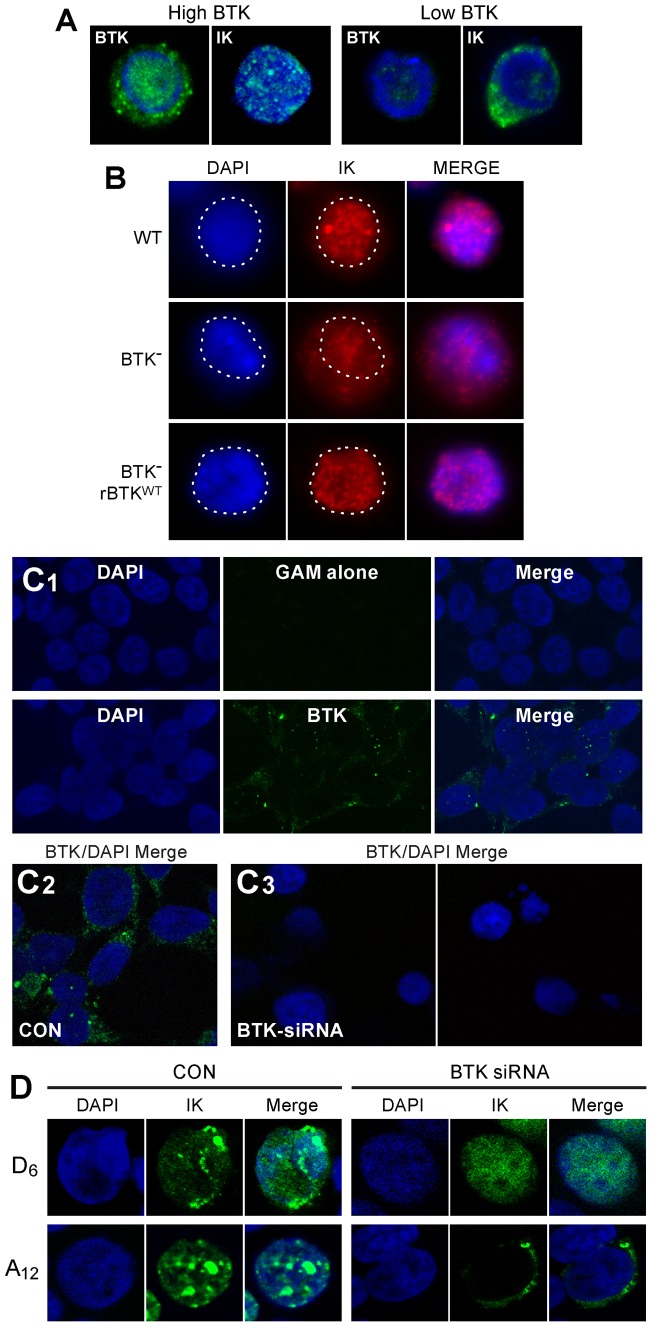
BTK Expression Levels Control Nuclear Localization of Ikaros.[A] Cells were stained with mouse monoclonal antibody (mAb) against human BTK and an anti-IK mouse mAb, which was raised against murine IK and which cross-reacts with human IK. TOTO-3 was used for nuclear staining. Depicted are the confocal two-color (green/blue: BTK/TOTO-3 and IK/TOTO-3) merge images of abundantly BTK+ (high BTK) leukemic cells from a pediatric B-precursor ALL case vs. leukemic cells with low BTK expression level from an infant B-precursor ALL case. Nuclear staining for IK was observed in the confocal fluorescence images of primary leukemic B-cell precursors with high BTK expression level. By contrast, leukemic cells with low BTK expression levels showed an aberrant, predominantly cytoplasmic localization of IK (System Magnification: 500×). [B] The DT-40 cell line and its subclones were stained with the rabbit polyclonal, H-100 (sc-13039) antibody against the N-terminus of IK. Depicted are the confocal two-color (red/blue) IK/DAPI merge images of wildtype (WT) DT40 cells, BTK-deficient DT40 cells, and BTK-deficient DT40 cells reconstituted with wildtype btk. The contour of the DAPI-stained nuclei (blue) was marked with a dotted line and shows a significant amount of IK protein (red) outside the nucleus of the BTK− DT40 cells. [C1] Upper panel: Depicted are the confocal single-color and two-color merge images of control Hek293T cells stained with the secondary goat anti-mouse (GAM) antibody and DAPI. No false positive green fluorescence was detected (System Magnification: 630×). Lower panel: Depicted are the confocal single-color and two-color (green/blue: BTK/DAPI) merge images of test Hek293T cells stained with anti-BTK/goat-anti-mouse (GAM) antibody combination and DAPI. BTK (green fluorescence) was localized primarily in the cytoplasm of Hek293T cells around the DAPI-stained blue nucleus. [C2] Left panel: Merge confocal images of untreated control Hek293T cells two-color stained with anti-BTK/goat-anti-mouse (GAM) antibody combination and DAPI. Right panel: Merge confocal images of BTK-siRNA transfected Hek293T cells two-color stained with anti-BTK/goat-anti-mouse (GAM) antibody combination and DAPI 72 h post-transfection. (System Magnification: 630×). BTK depletion was confirmed by Western blot analysis (see Figure 3) [D] Confocal images of Hek293T cells expressing the HA-tagged mutant IK proteins D6 or A12 stained with the mouse monoclonal anti-HA antibody (HA-probe F-7)(primary Ab)/Alexa Fluor 488 goat anti-mouse IgG (secondary Ab) (green) antibody and blue fluorescent DNA dye 4′, 6-diamidino-2-phenylindole (DAPI) following treatment with BTK siRNA (50 nM) vs. PBS (CON). (System Magnification: 630×).